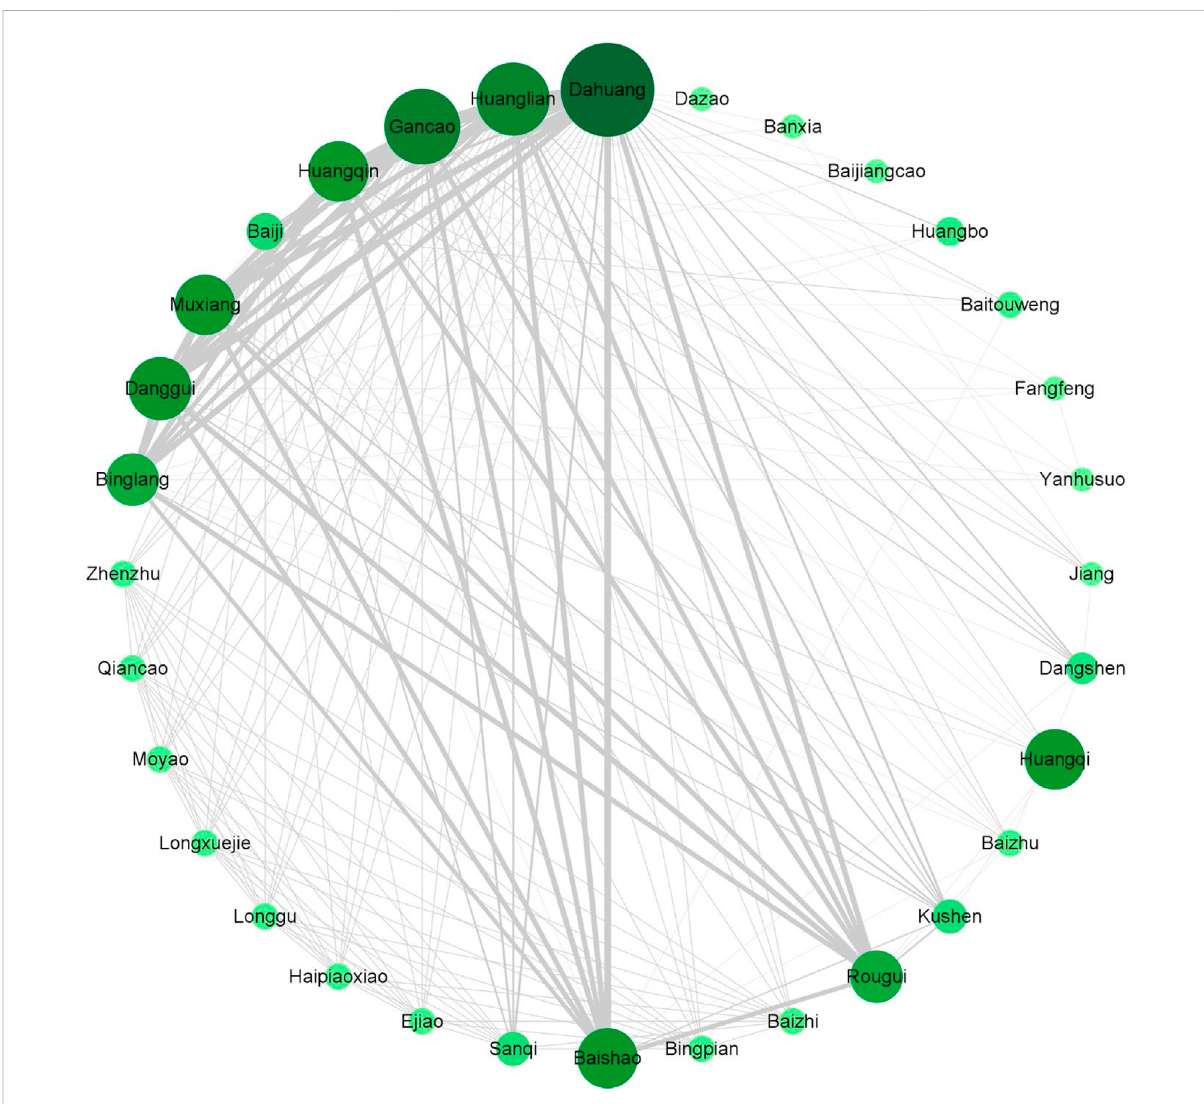
FIGURE 13 Acomplexnetworkanalysisoftherhubarb-basedmedicinalformulas.Thesizeandcolorofthenodesrepresentthefrequencyofoccurrenceof themedicinals.Thelarger and darkerthenode, themore frequentlythemedicinalsappear.The degree ofassociation between medicinalsismarked by lines, the thicker the line and the darker the color, the stronger the association between two botanical drugs.